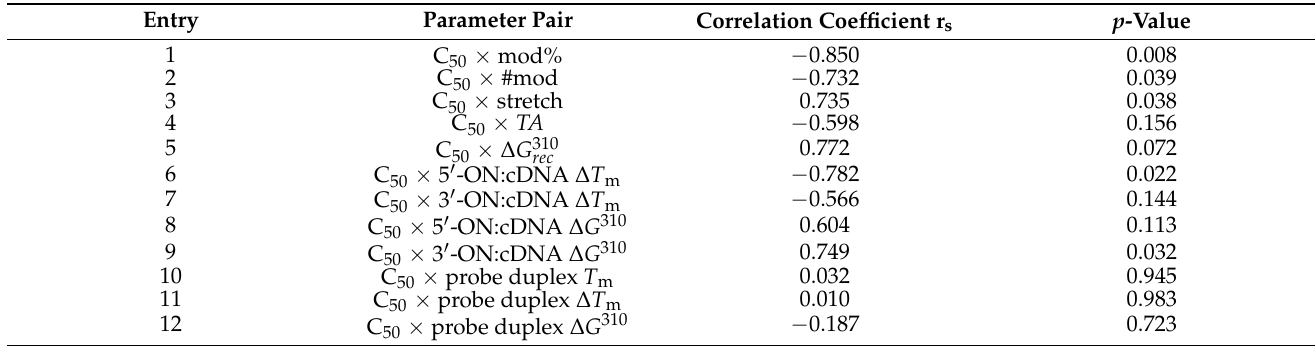
Table 4. Selected data from our Spearman’s rank-order correlation analysis pertaining to Invader- mediated recognition of DNA hairpins and chromosomal DNA in FISH assays a